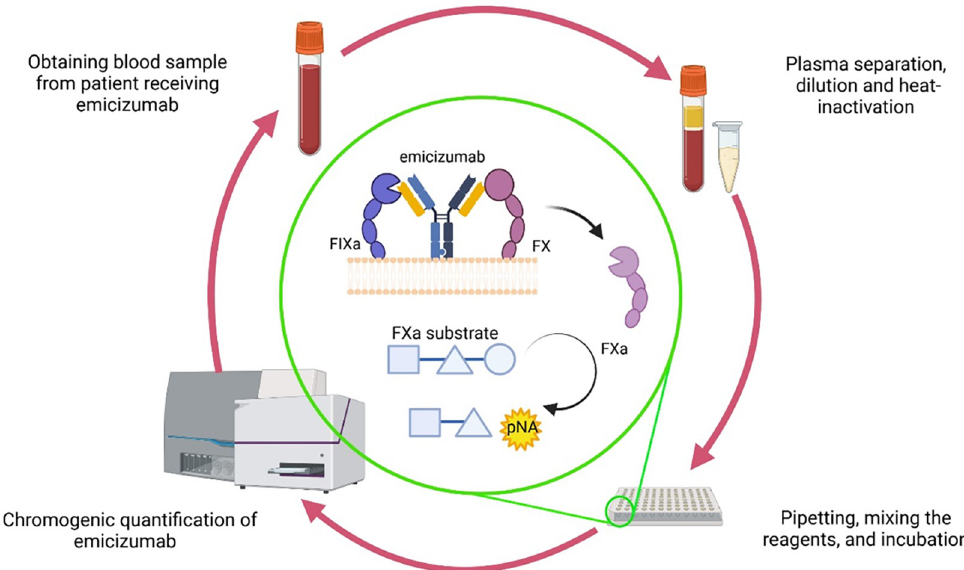
Fig 1. Principle of the two-stage chromogenic assay procedure for quantification of emicizumab plasma levels.